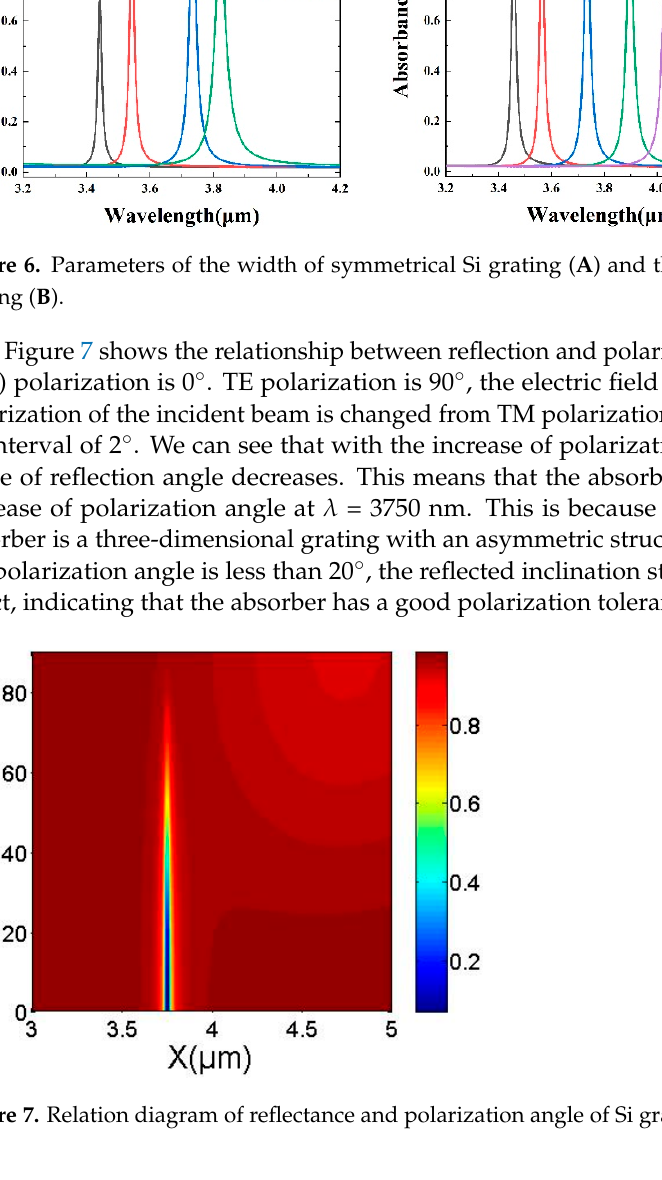
Figure 7. Relation diagram of reflectance and polarization angle of Si grating.